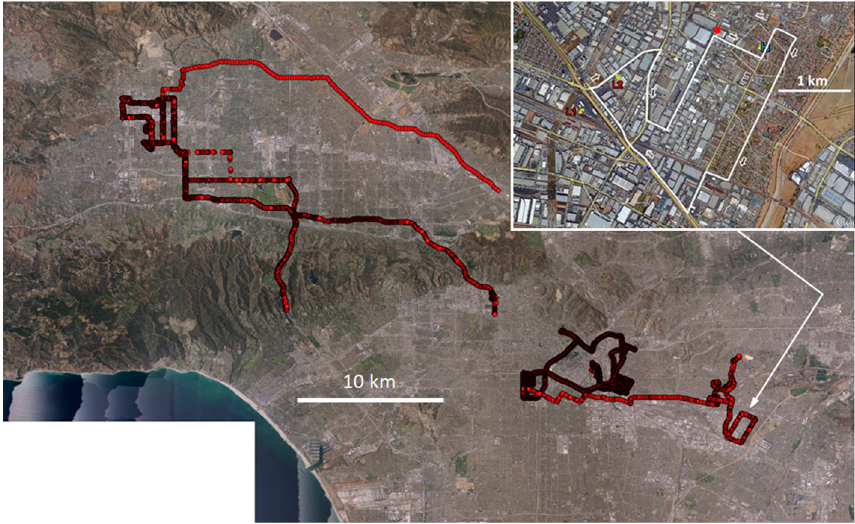
Figure 8. Superimposed routes of 15 transects. Inset: a randomly-selected transect detail.